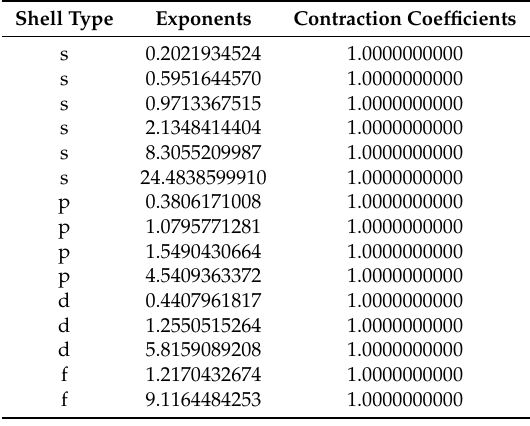
Table A26. Parameters of the cc-DZVP auxiliary basis set of Argon.